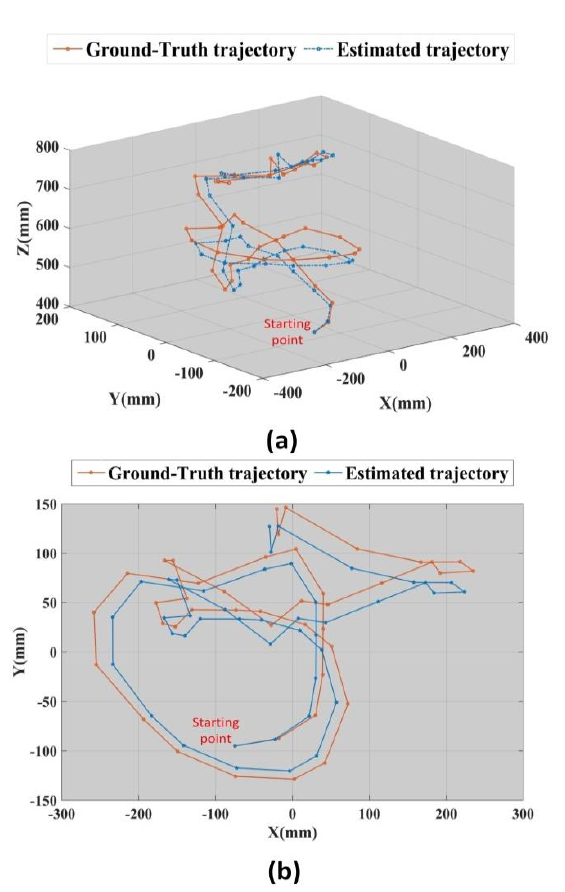
Figure 9. Ground-Truth and estimated trajectory of camera (a) in 3D and (b) projection on XY plane.